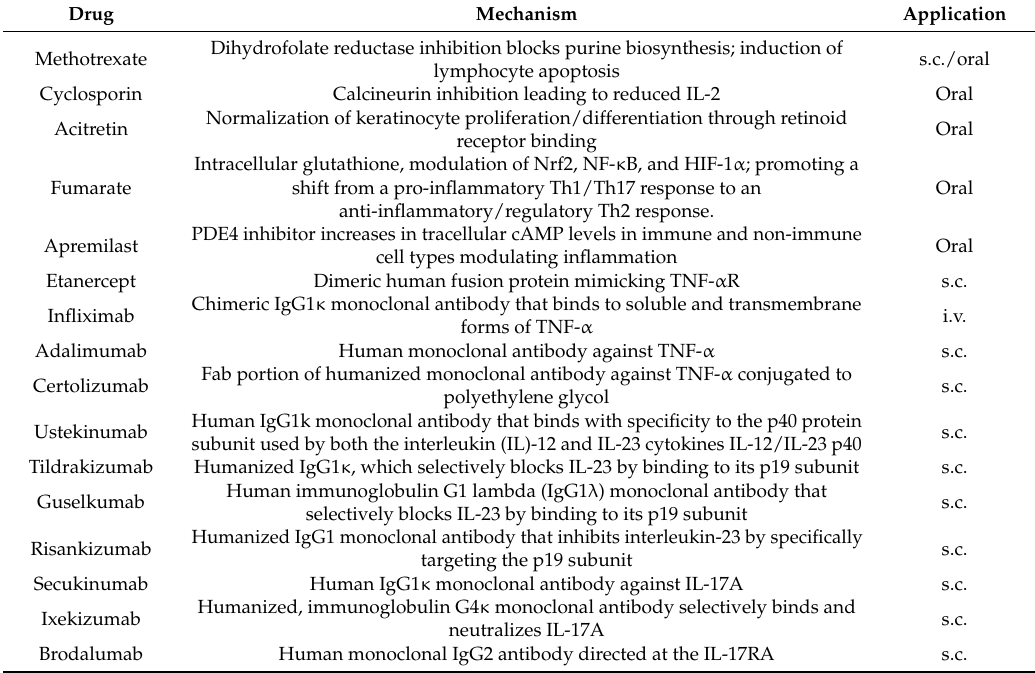
Table 3. Drugs available for psoriasis